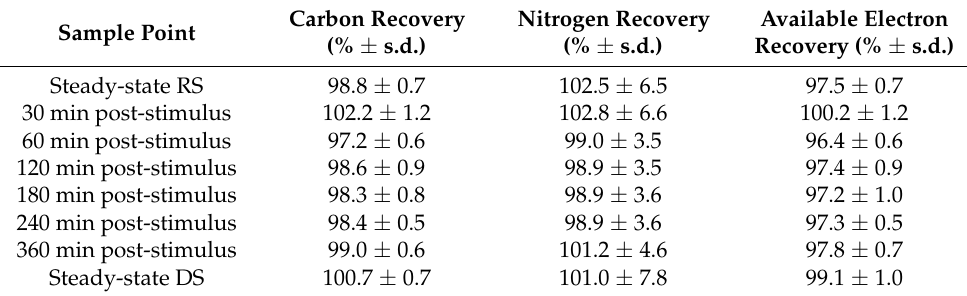
Table 1. Process balances at sample points relevant for this study.